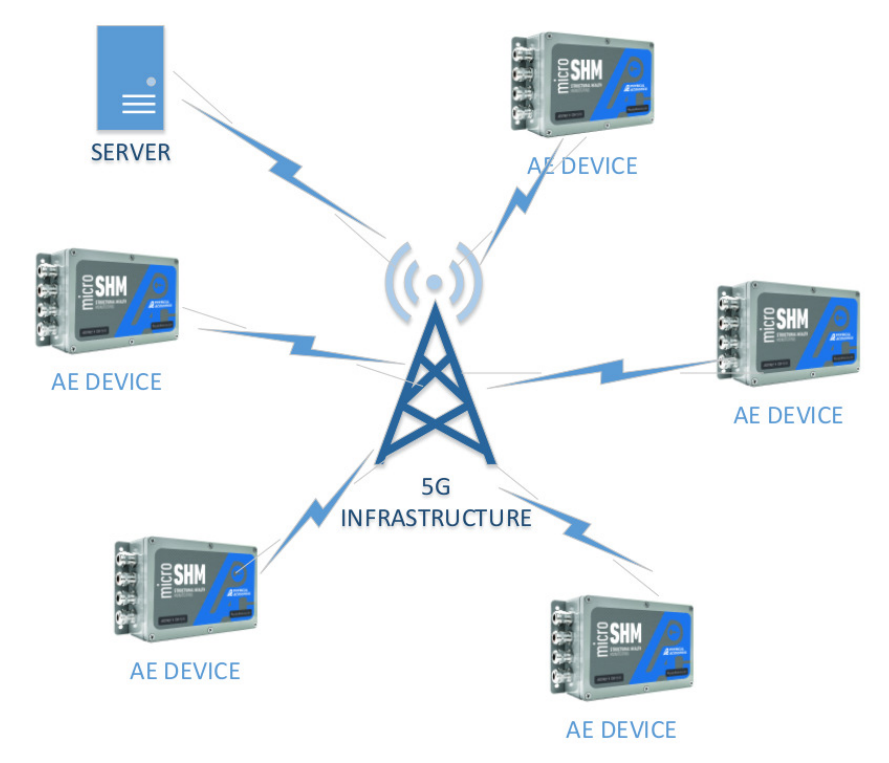
Figure 2. Telecommunication